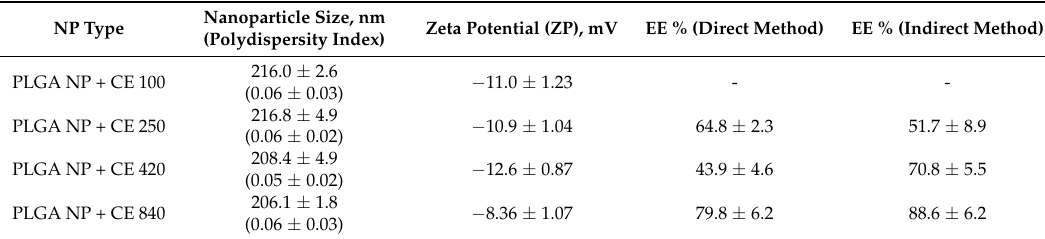
Table 1. Characteristics of poly(lactic- co -glycolic acid) (PLGA) nanoparticles (NPs) loaded